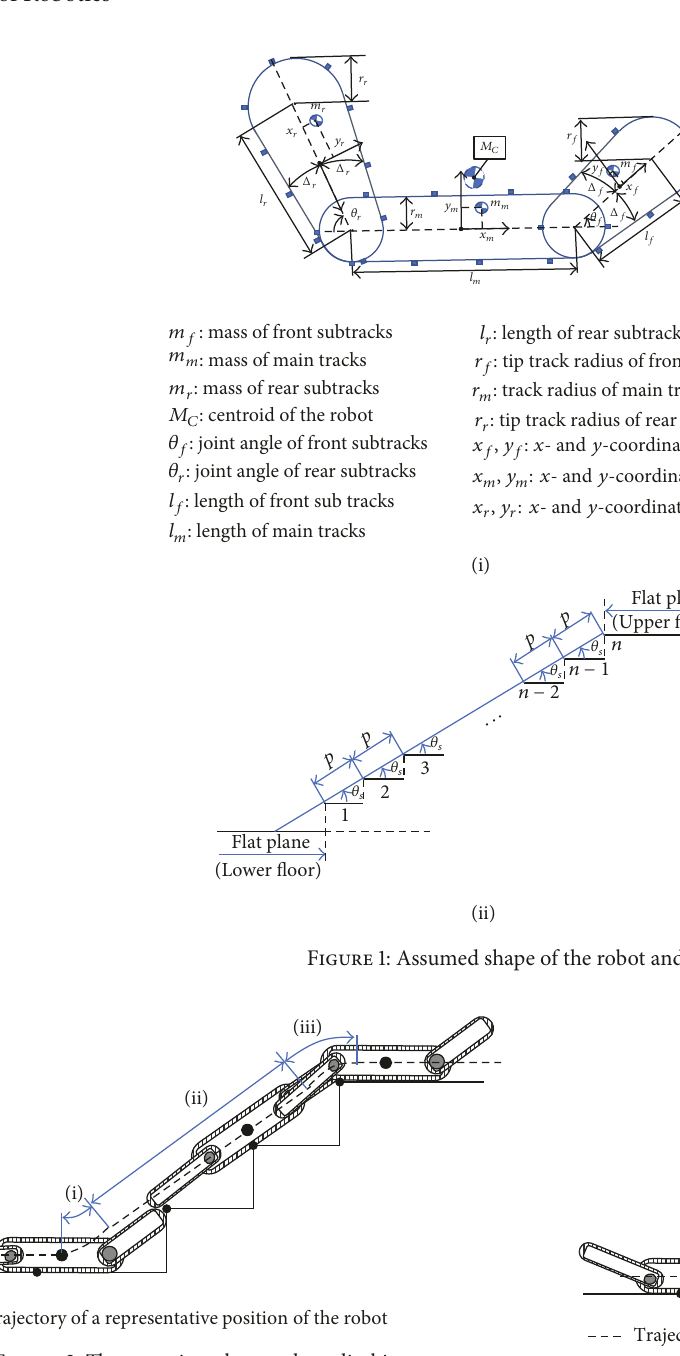
Figure 3: Four motion phases when climbing